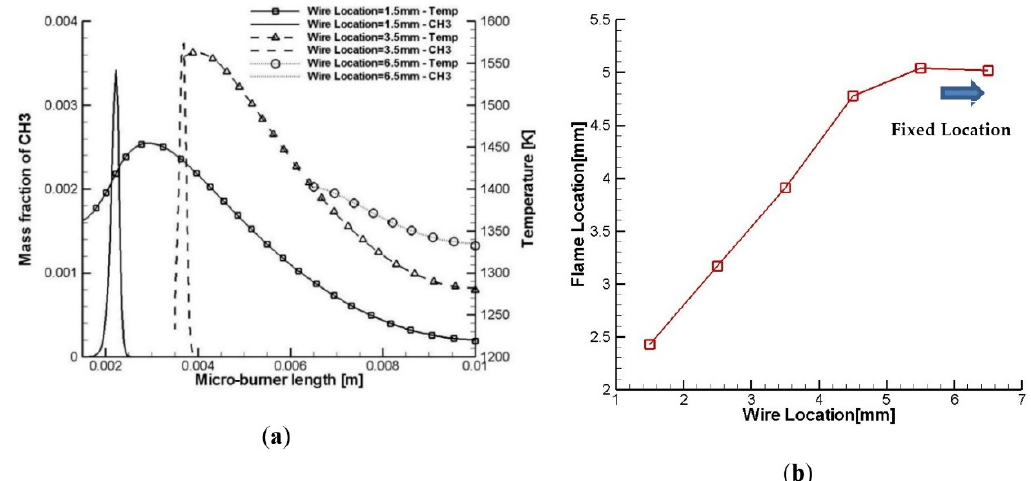
Figure 8. Contours of OH mass fraction in the micro-burner for different locations of the inserted wire.